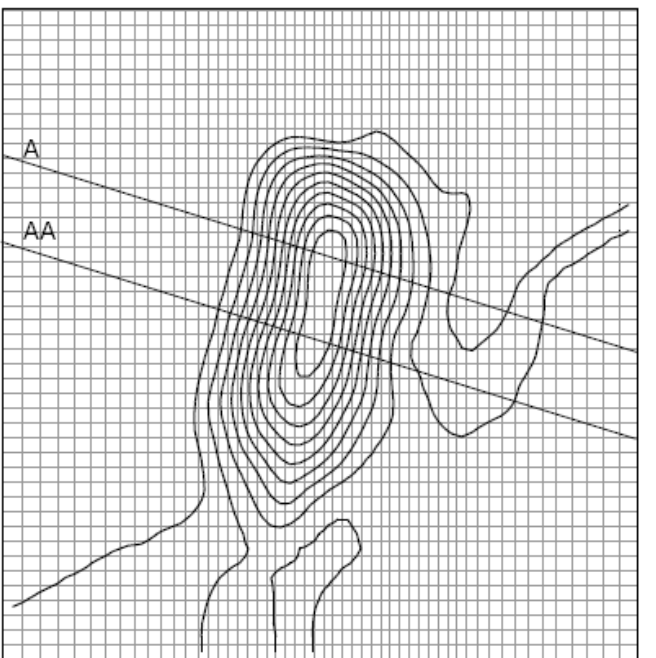
Figure 20. Elevation contours and grid distribution for the simulation of the Askervein Hill [67]. Reproduced with permission